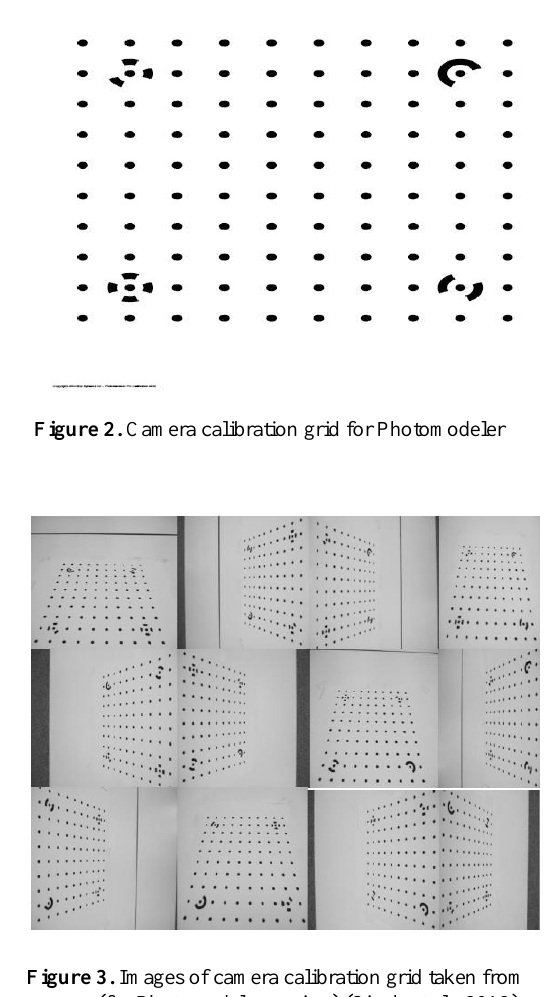
Figure 3. Images of camera calibration grid taken from camera (for Photomodeler project) (Singh et al., 2012)